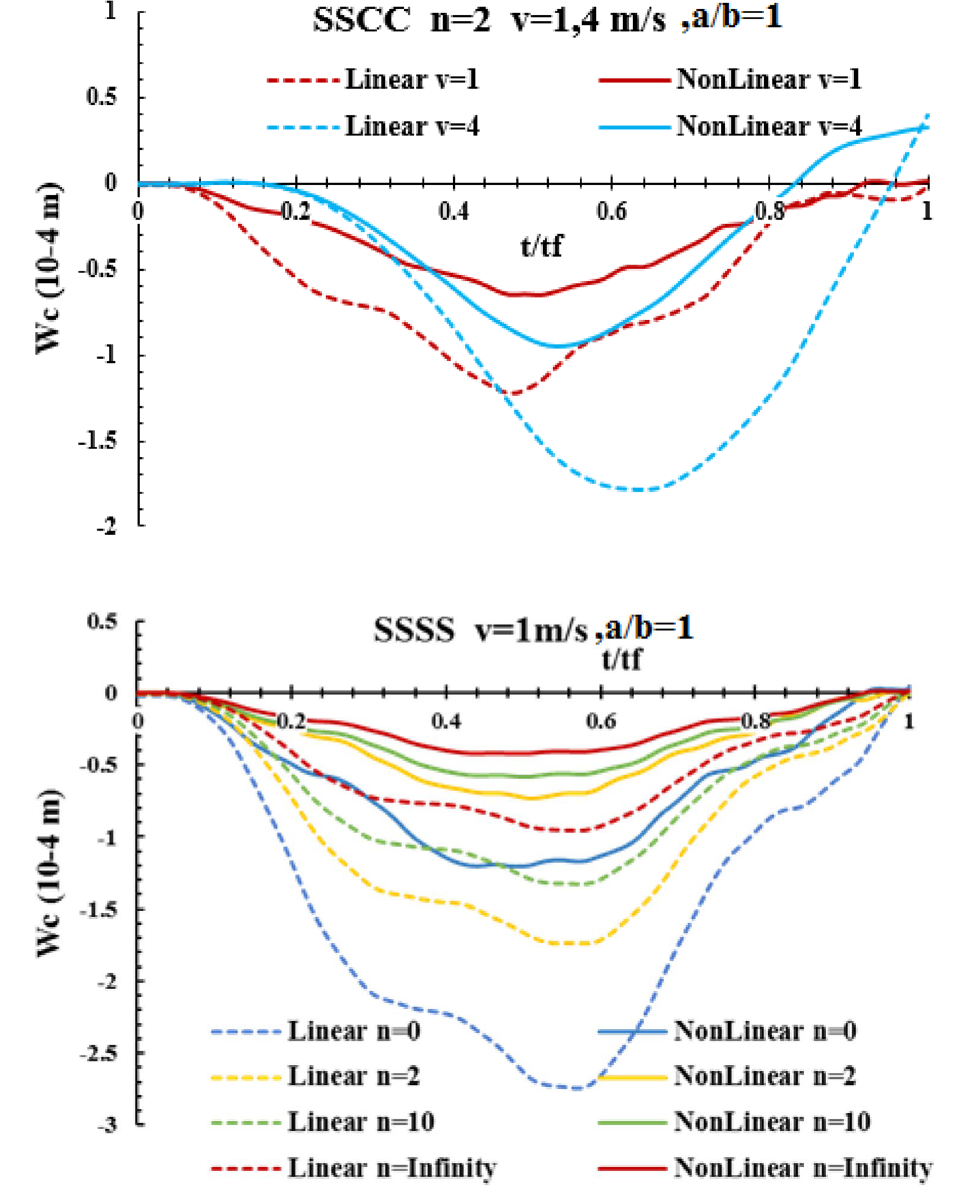
Fig. 11 The effect of velocity of moving force on deflection history of center-point of the plate (SSCC boundary condi- tion)